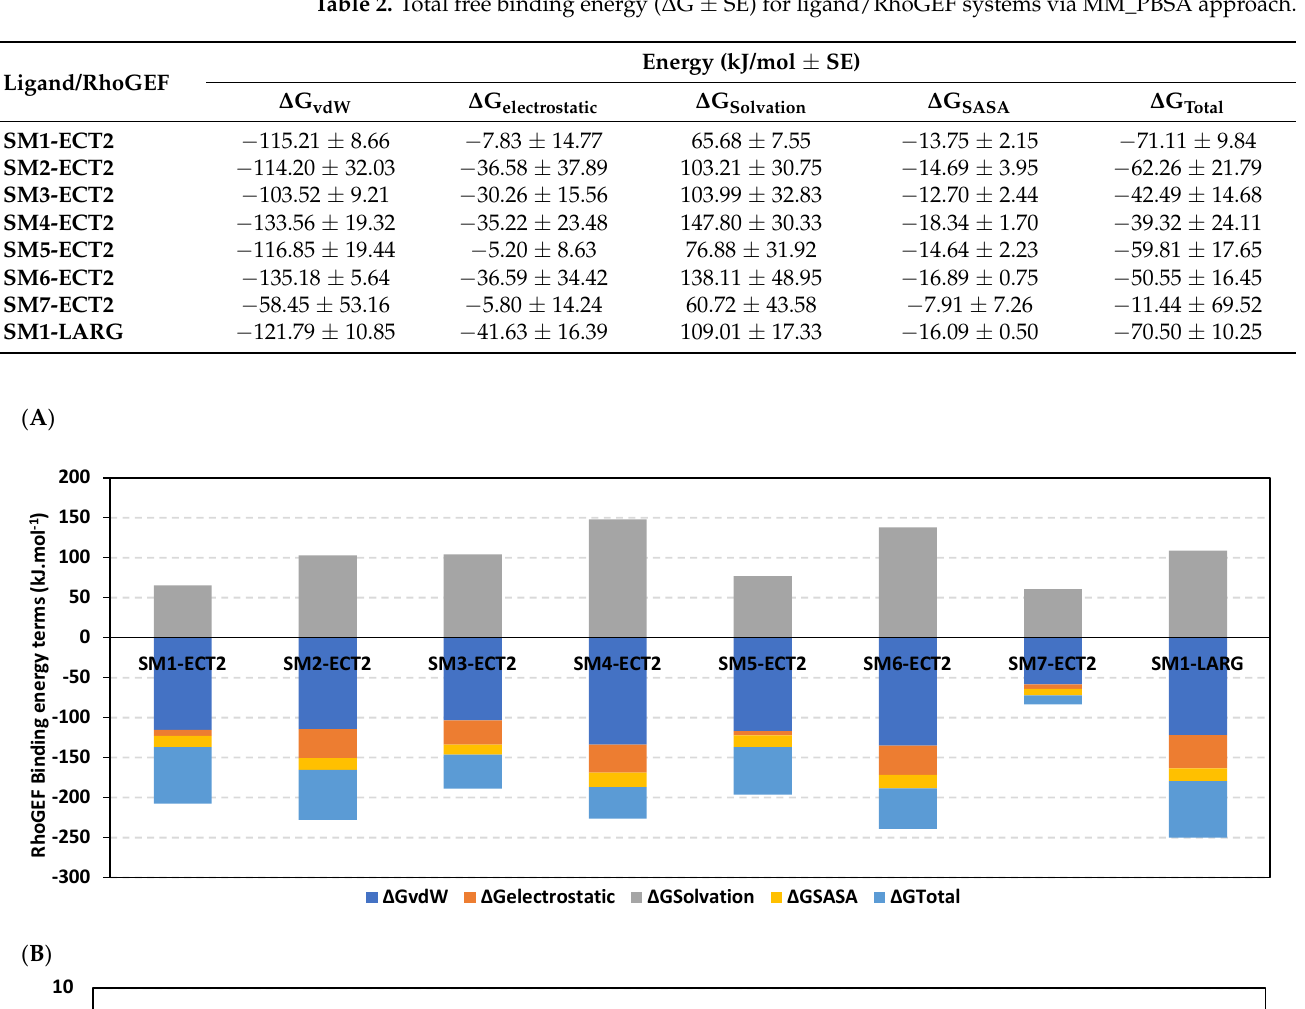
Table 2. Total free binding energy ( ∆ G ± SE) for ligand/RhoGEF systems via MM_PBSA approach.